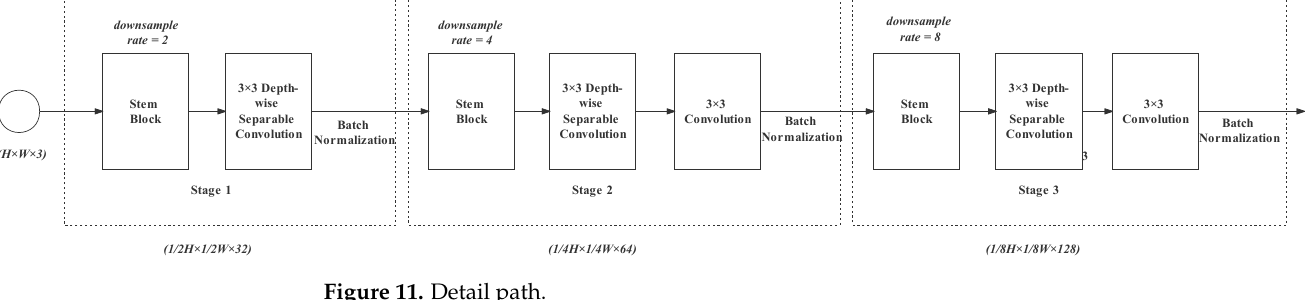
Figure 11. Detail